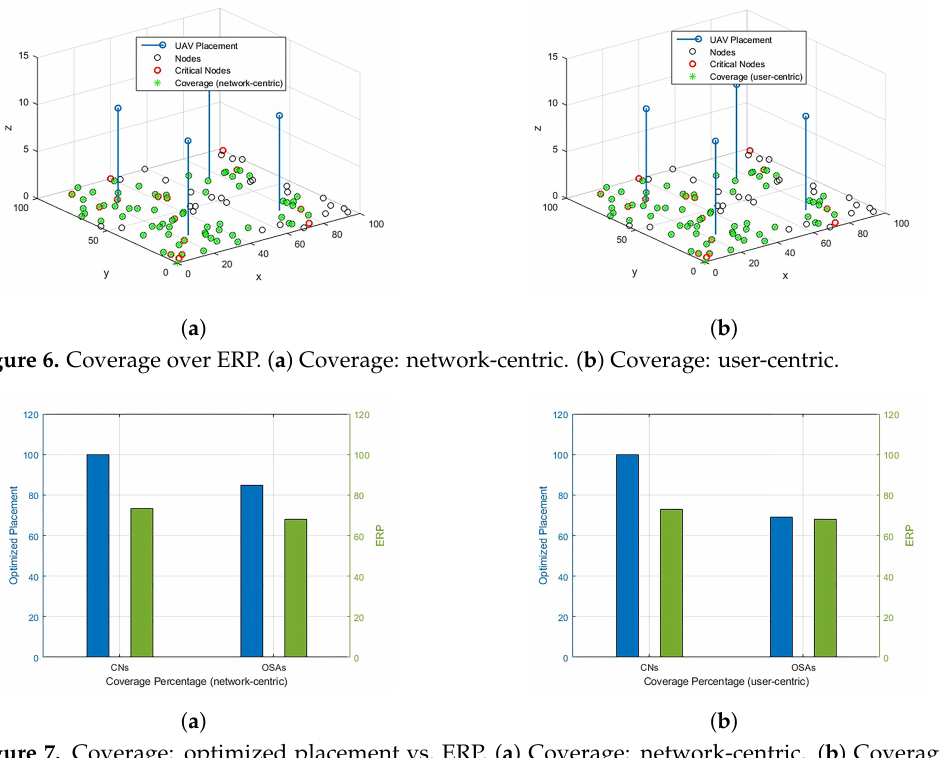
Figure 7. Coverage: optimized placement vs. ERP. ( a ) Coverage: network-centric. ( b ) Coverage: